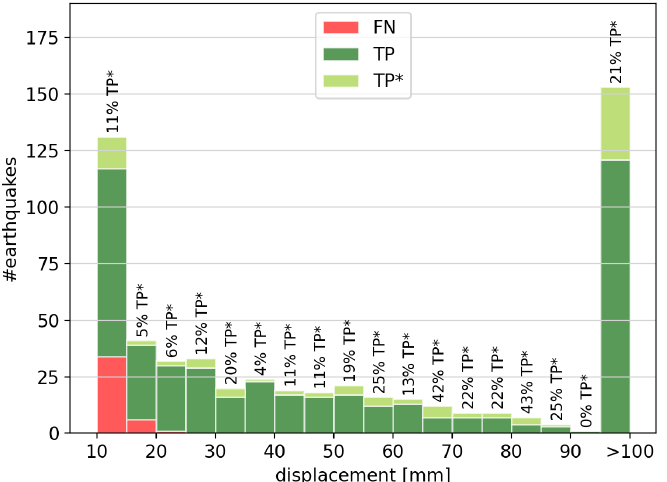
Figure 9. Earthquake displacement size for detected earthquakes (TP + TP*) and undetected earth- quakes